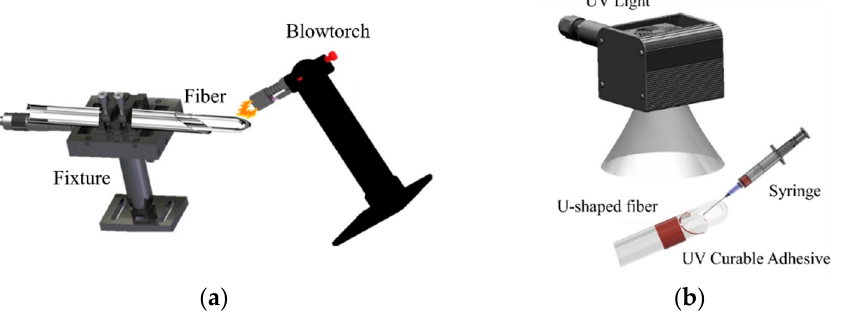
Figure 1. ( a ) Schematic of the fabrication of a U-shaped optical fiber via flame heating; ( b ) schematic of the UV curing and packaging